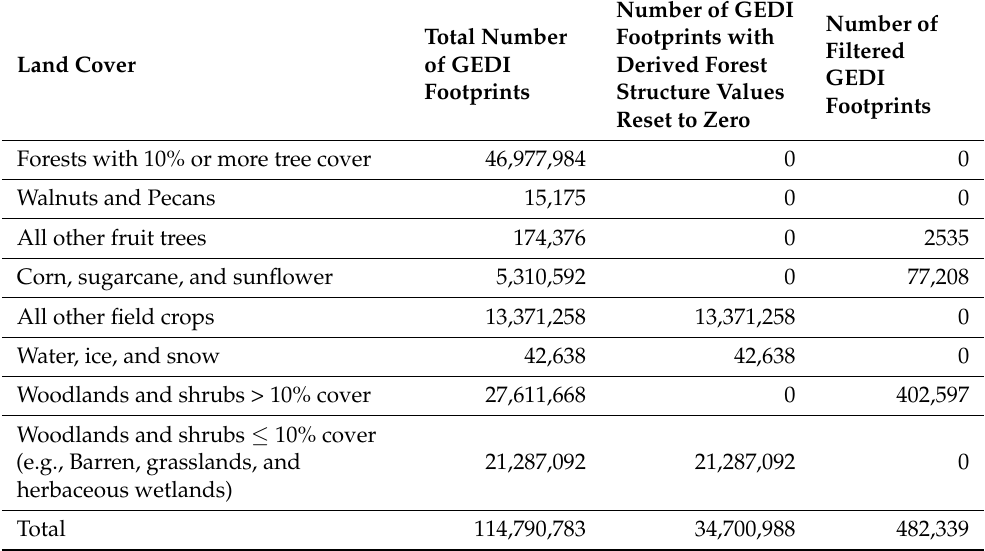
Table 4. Distribution of GEDI footprints per land cover type, the number of footprints where the GEDI-derived forest structure values were reset to zero, and the number of GEDI footprints not included in further analysis due to possible overestimation of vegetation canopy